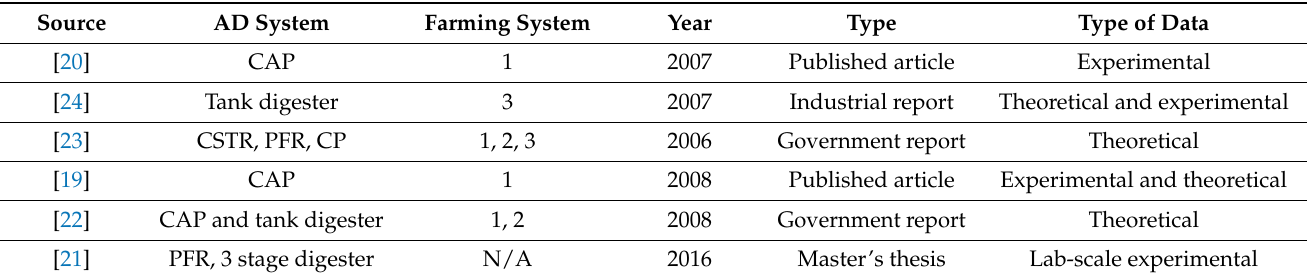
Table 2. Summary of the literature review.